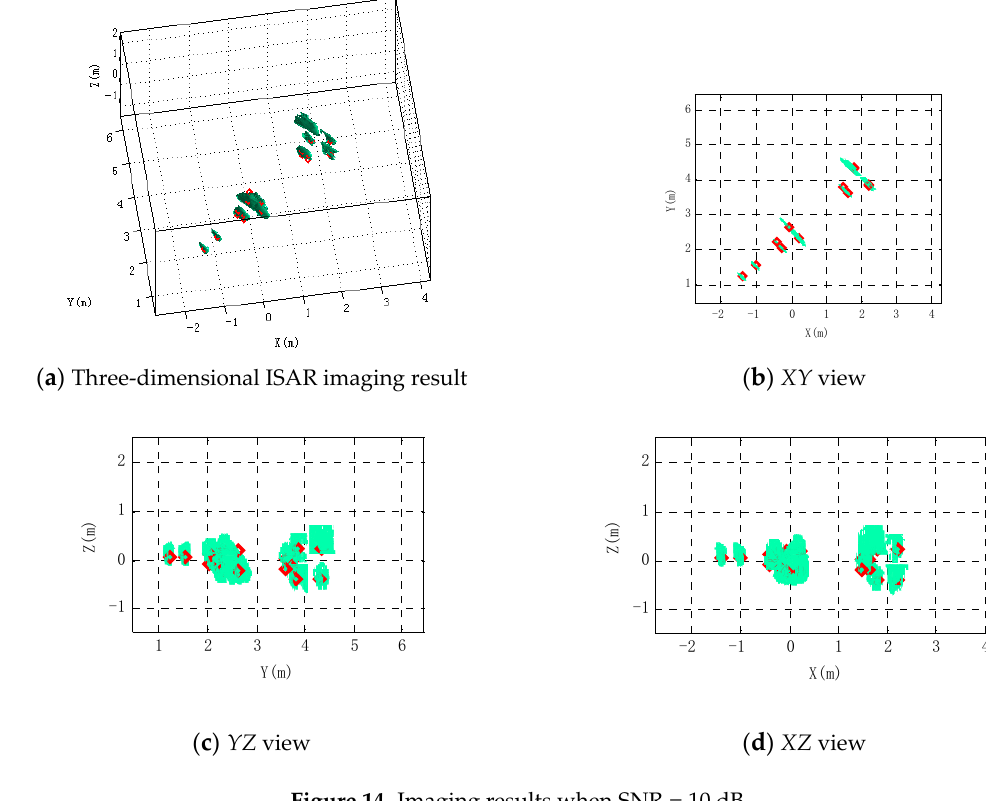
Figure 14. Imaging results when SNR = 10 dB.